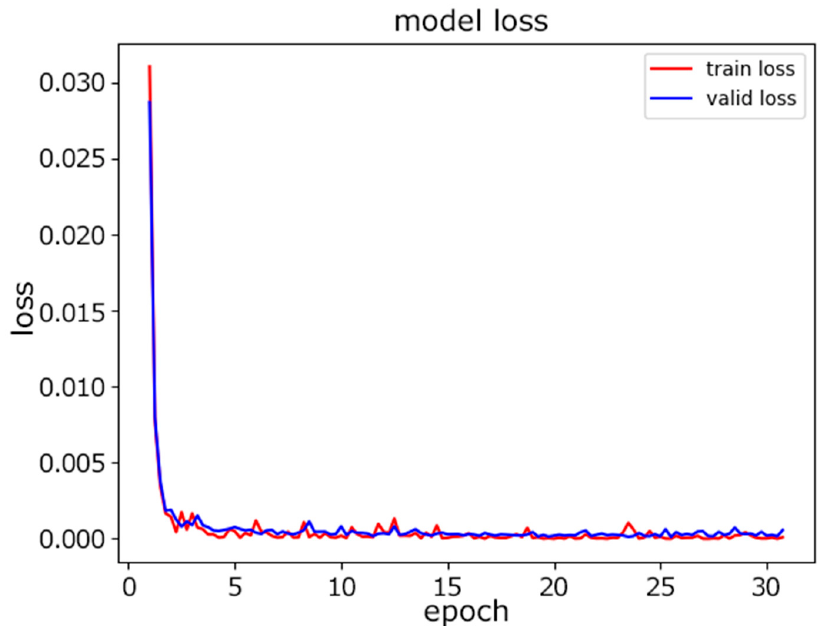
Figure 8. CNN model loss.